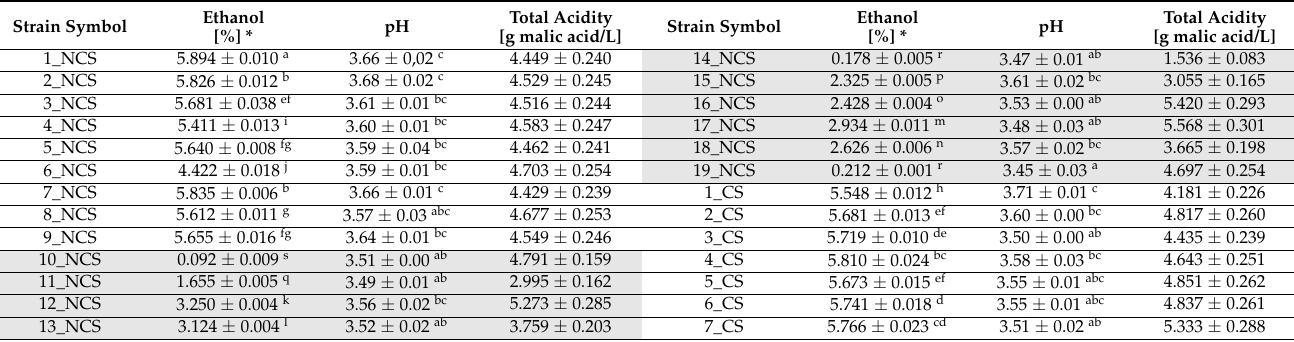
Table 2. Ethyl alcohol content, total acidity and pH after fermentation of test